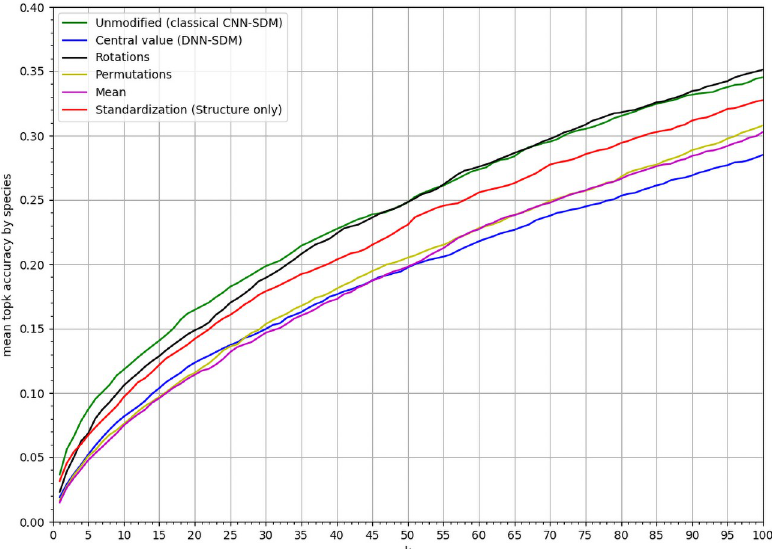
Fig 9. Results of ablation study. Results of the CNN with different tensor transformations in the ablation study: MSA of the ablated CNN-SDM model deprived for k values within [1,